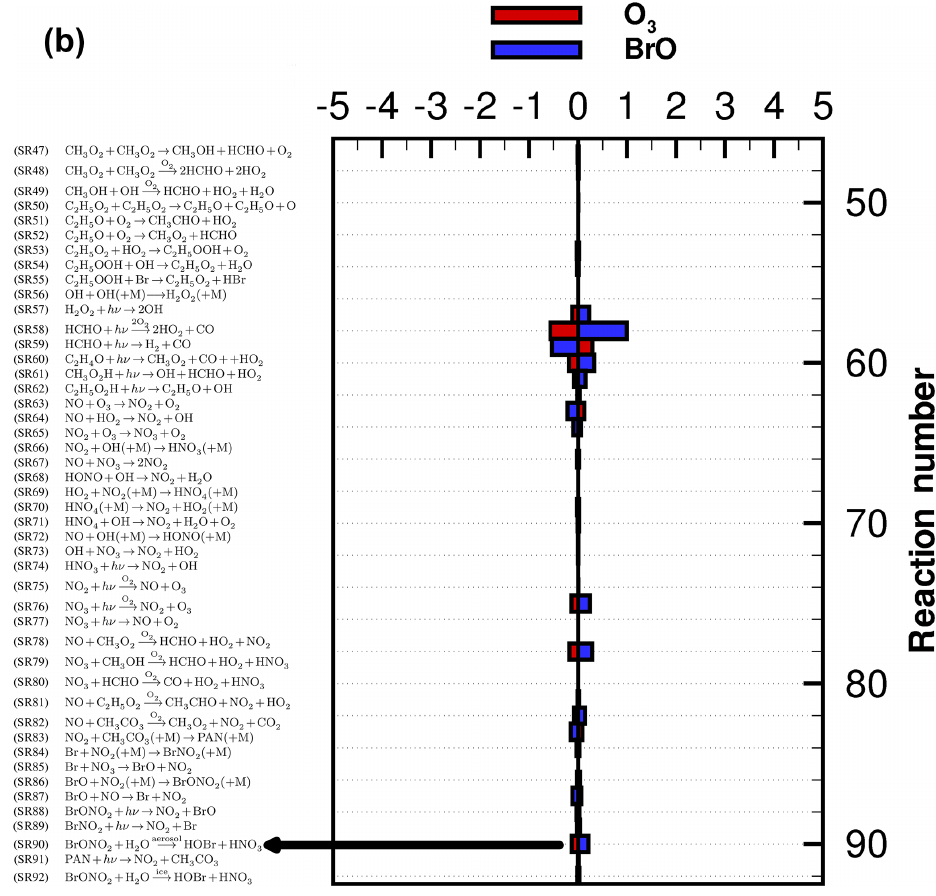
Figure 2. Relative concentration sensitivities of ozone and BrO for (a) Reactions (SR1)–(SR46) and (b) Reactions (SR47)–(SR92) within the time interval [day 3.9, day